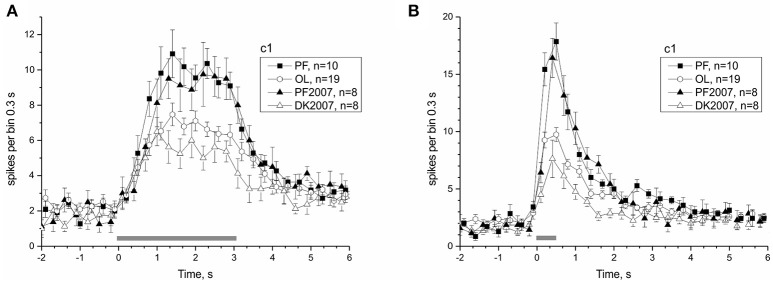
Comparison of Bion-M1 and Foton-M3 postflight groups reveals an independence of microgravity adaptation on mission duration. (A) Response to c1 stimulus with duration 3,050 ms. (B) Response to c1 stimulus with duration 550 ms. Filled symbols represent PF snails and open symbols the corresponding control snails (see legend box).